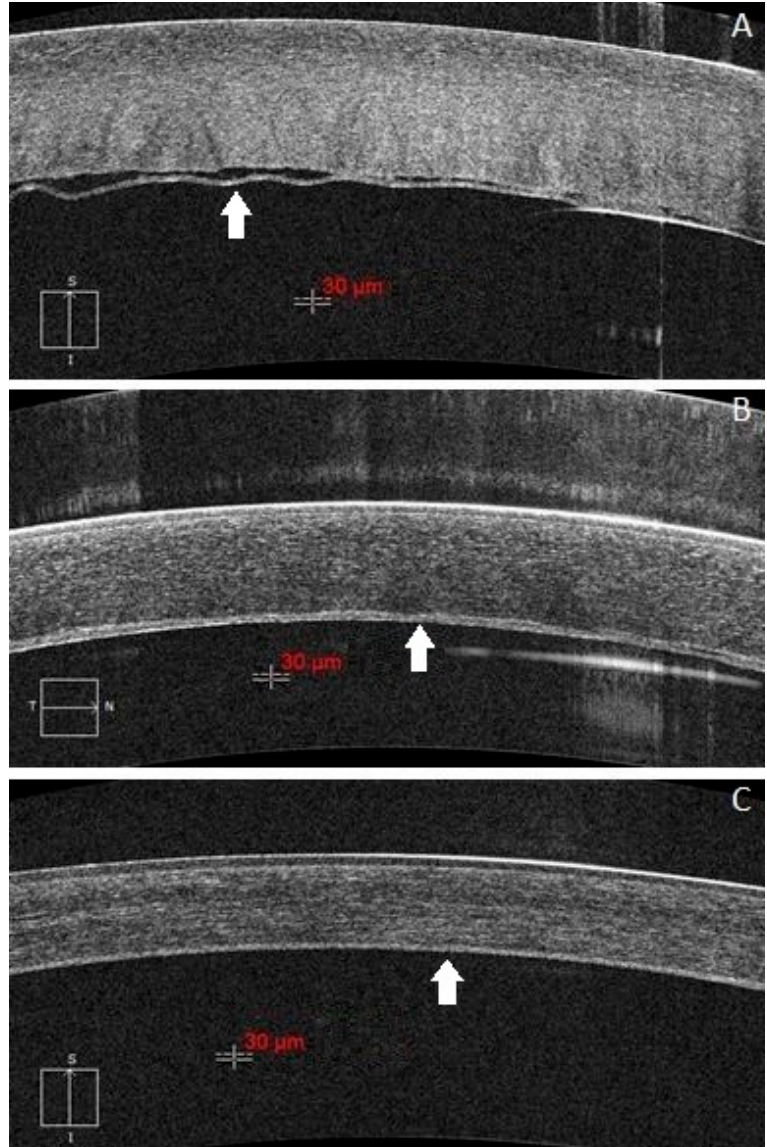
Figure 2. The boundary between the corneal stroma and EDM in HD-OCT images are clear after DM reattachment in dDALK patients. ( A ): One case of a 16-year-old male with keratoconus and underwent dDALK in his right eye, the EDM (white arrow) was partial separated from the graft on the first post-operative day. ( B ): The DM reattached spontaneously, but the thickness of EDM was uneven due to inflammation at 1 month after DM reattachment. ( C ): The inflammation has subsided and the thickness of EDM was stable and clear for measurement at 3 months after DM reattachment.